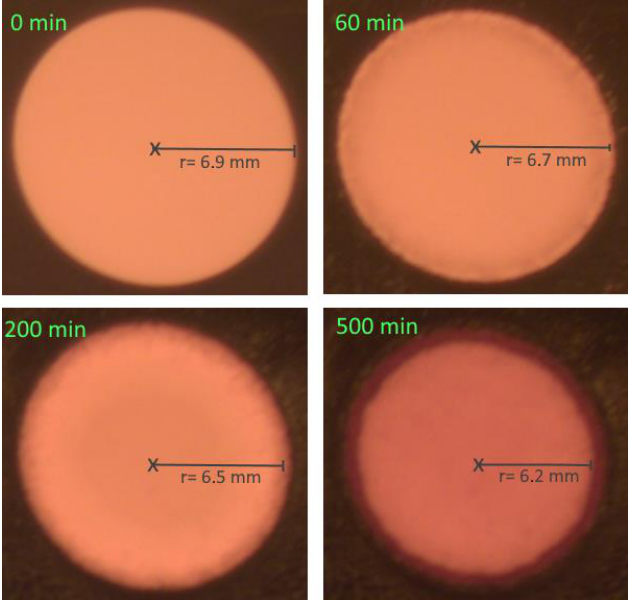
Figure 3. The specimen immersed in the corroding agent. The exposed copper surface immediately begins to corrode (brown/black), while the PDMS drop protects the underlying copper (red/orange). Pictures show the advancing corrosion at different time stages. With full corrosion of the copper the radius r of the drop begins to decline due to the corroding agent penetrating the interface and corroding the underlying copper.